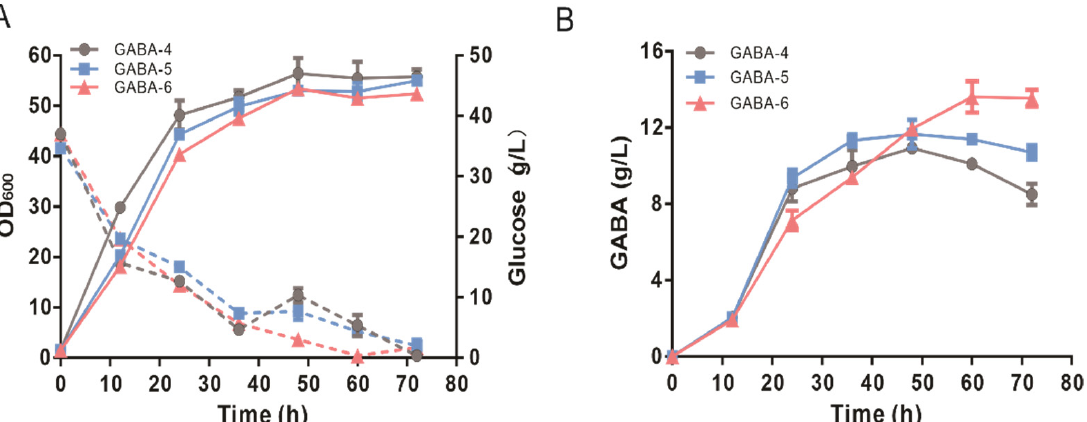
Figure 4. The effects of blocking the GABA shunt pathway and rewiring the GABA transport system on GABA production. ( A ) Time profiles of cell growth and glucose concentration during the shake flasks. The solid lines represent the growth, and the dotted lines represent the glucose concentration. ( B ) Time profile of GABA production during the shake flasks. Data shown are mean values with the standard deviation from three biological replicates.